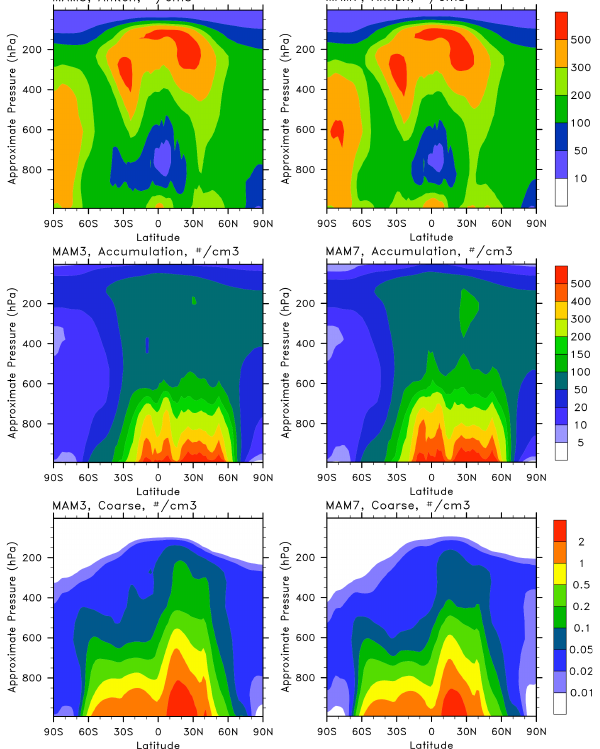
Fig. 6. Same as Fig. 5, except for annual and zonal mean aerosol Figure 6. Same as Figure 5 except for annual and zonal mean aerosol number number concentrations in Aitken, accumulation and coarse mode. concentrations in Aitken, accumulation and coarse mode.